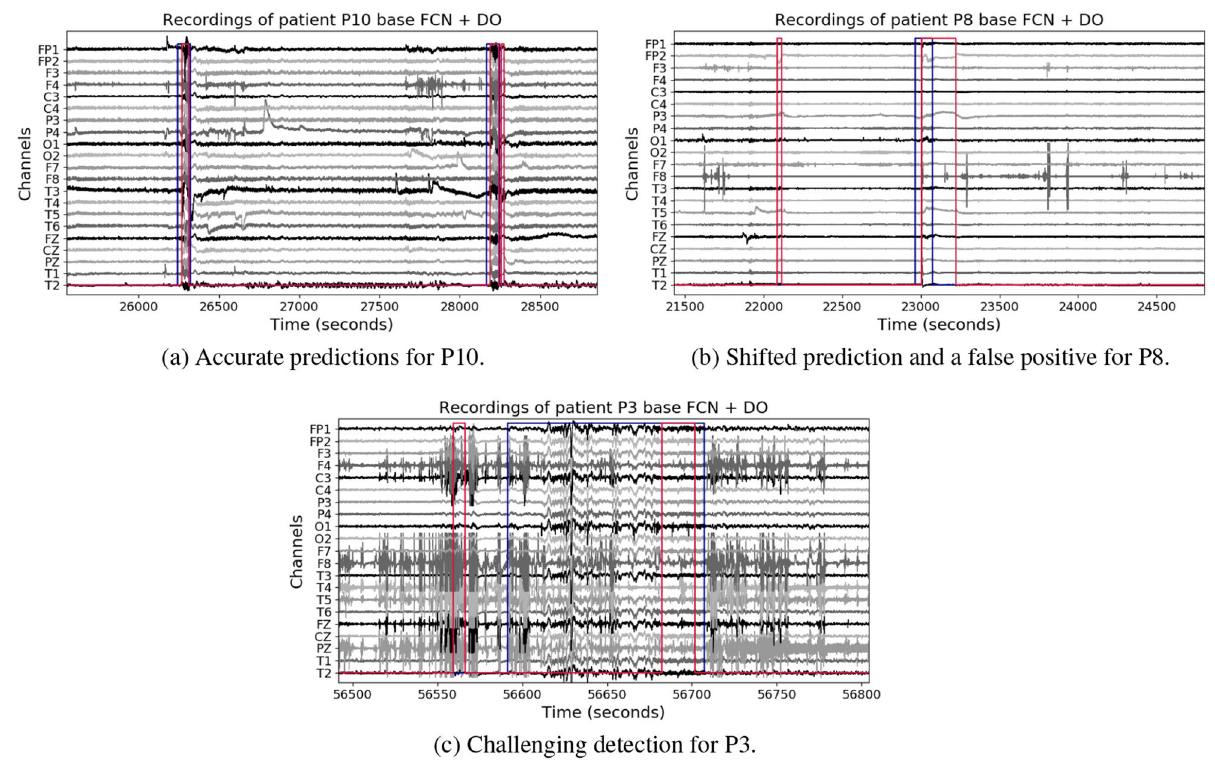
Figure 7. Qualitative results in the evaluation recordings of the best scalp model in the EPILEPSIAE patients. The y-axis shows the monopolar electrodes, and the x-axis the time in seconds. Blue lines correspond to annotations, and red lines to